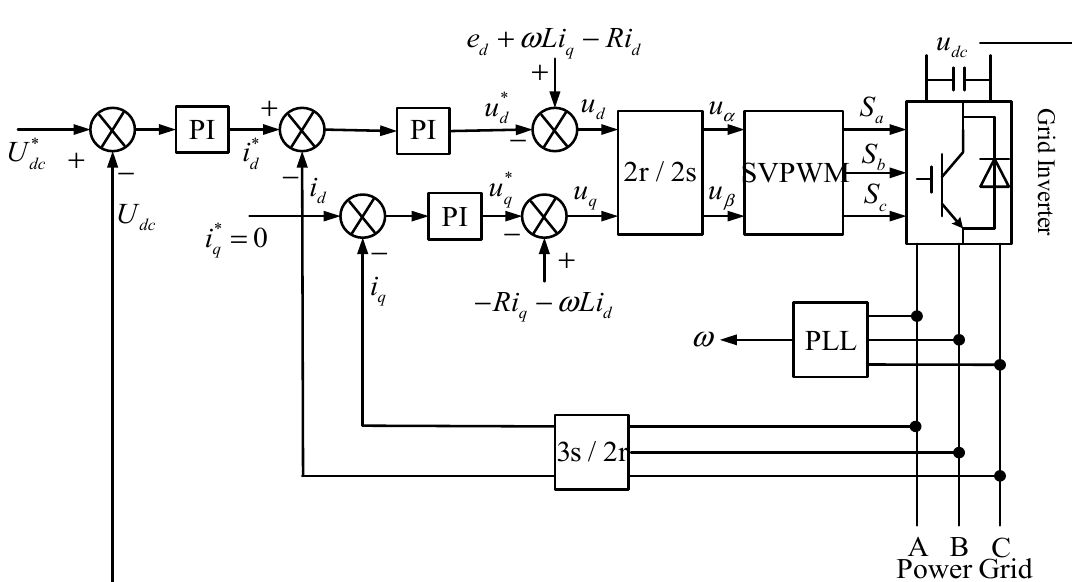
Figure 4. Control block diagram of grid-connected inverters under traditional control mode. k to be the proportional and integral coefficients of the voltage outer loop k and Set ui up k k and controller respectively, ii ip